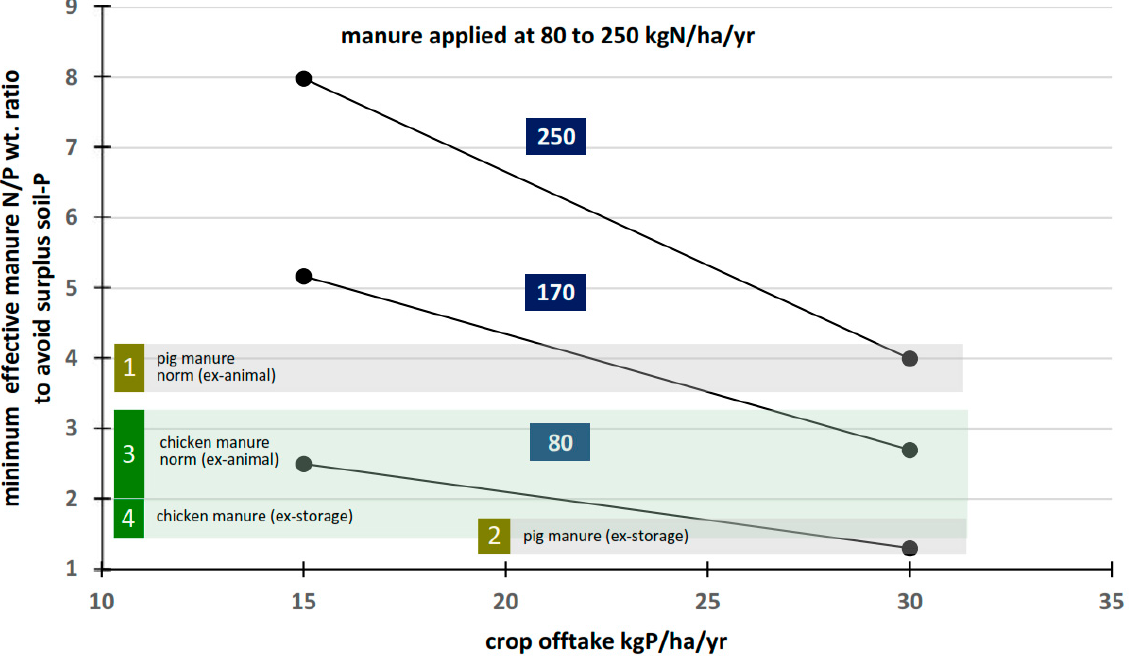
Figure 11. Graphic showing the minimum effective N/P ratios of applied manure and crop P offtake levels (kgP/ha/year) that are required to avoid surplus soil P at stored manure application rates of 80, 170, and 250 kgN/ha/year. The area under each line represents a situation with potential surplus P. Band 1 represents the range of N/P values in ex-animal manure from sows, piglets, and fattening pigs (Danish norms) [92]; band 2 is the N/P range for pig manure ex-storage [91]; bands 3 and 4 are the N/P ranges for ex-animal and ex-storage manure from broiler and egg-laying chickens (Finnish and Danish norms [92,93] and [34].